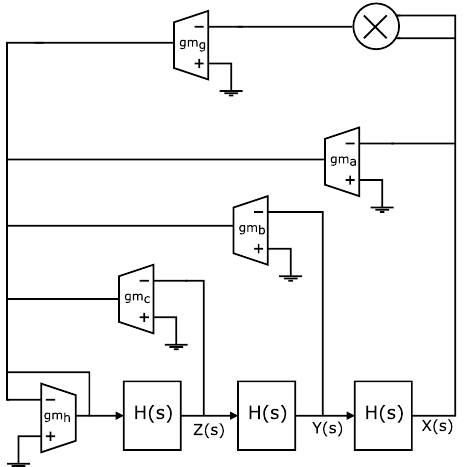
Figure 6. Proposed OTA implementation of the FOCO 1 given in